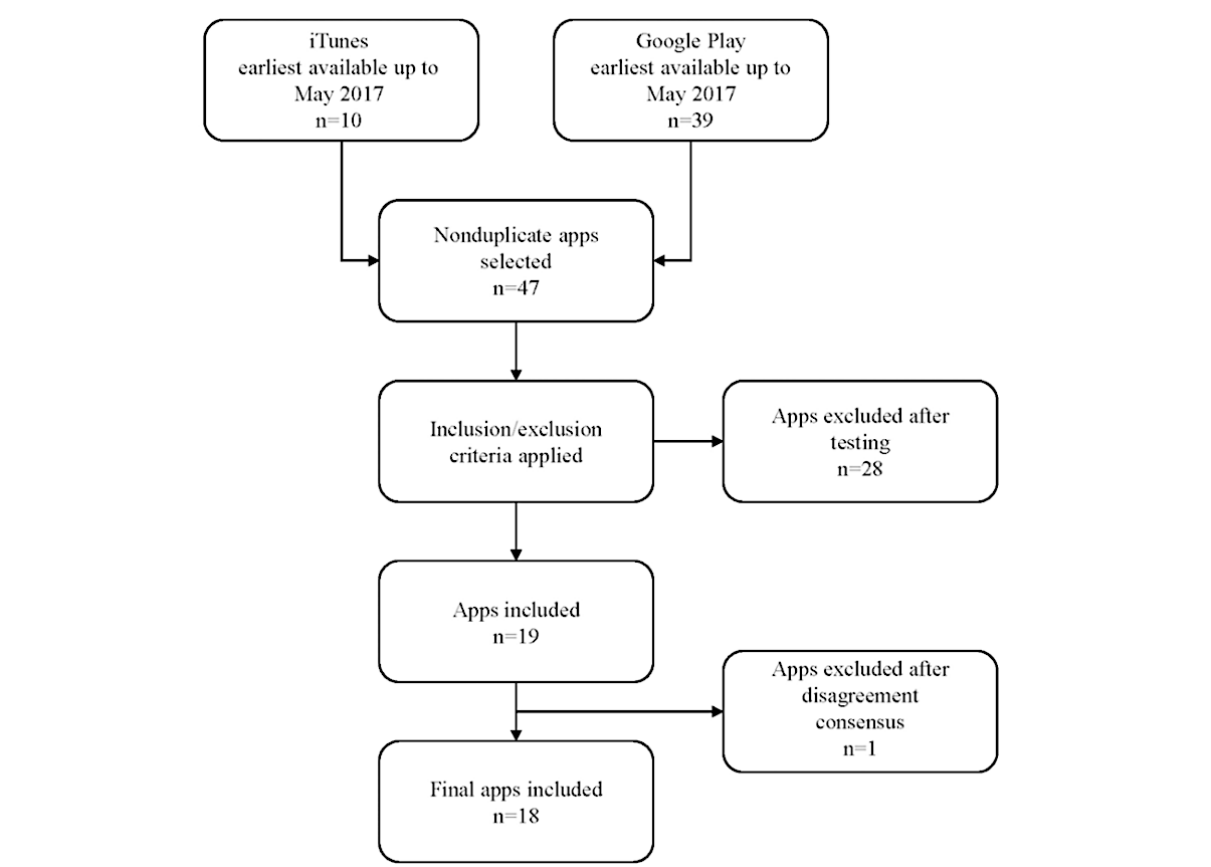
Figure 2. Flowchart of the pain-related app